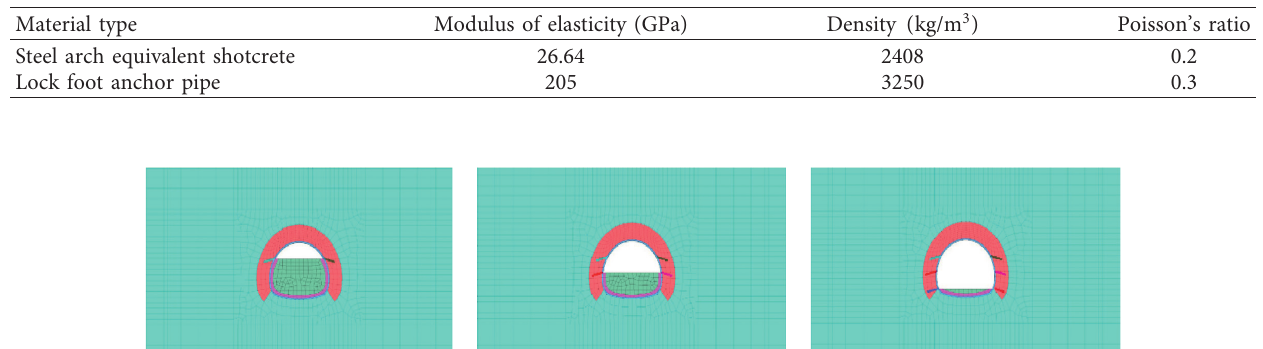
Table 2: Support